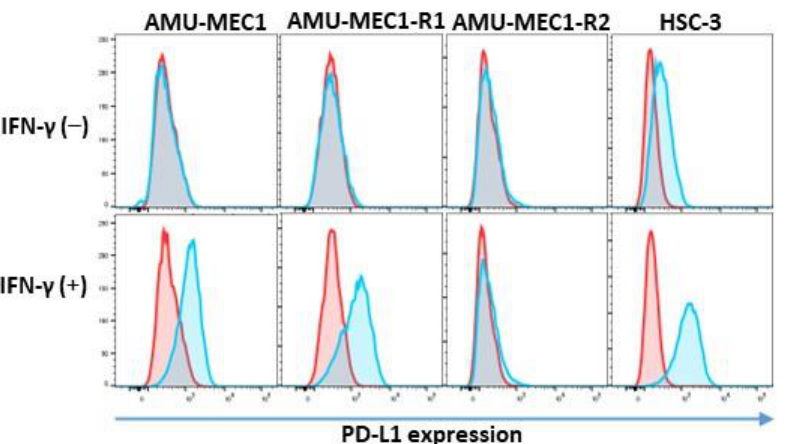
Figure 7. IFN- γ -induced PD-L1 upregulation in established cell lines. PD-L1 expressions in the ab- sence of IFN- γ (upper column) and after IFN- γ stimulation (lower column) are depicted, respectively. The HSC-3 cell line served as the positive control. The red histograms indicate the isotype control, while the blue histograms indicate anti-PD-L1.